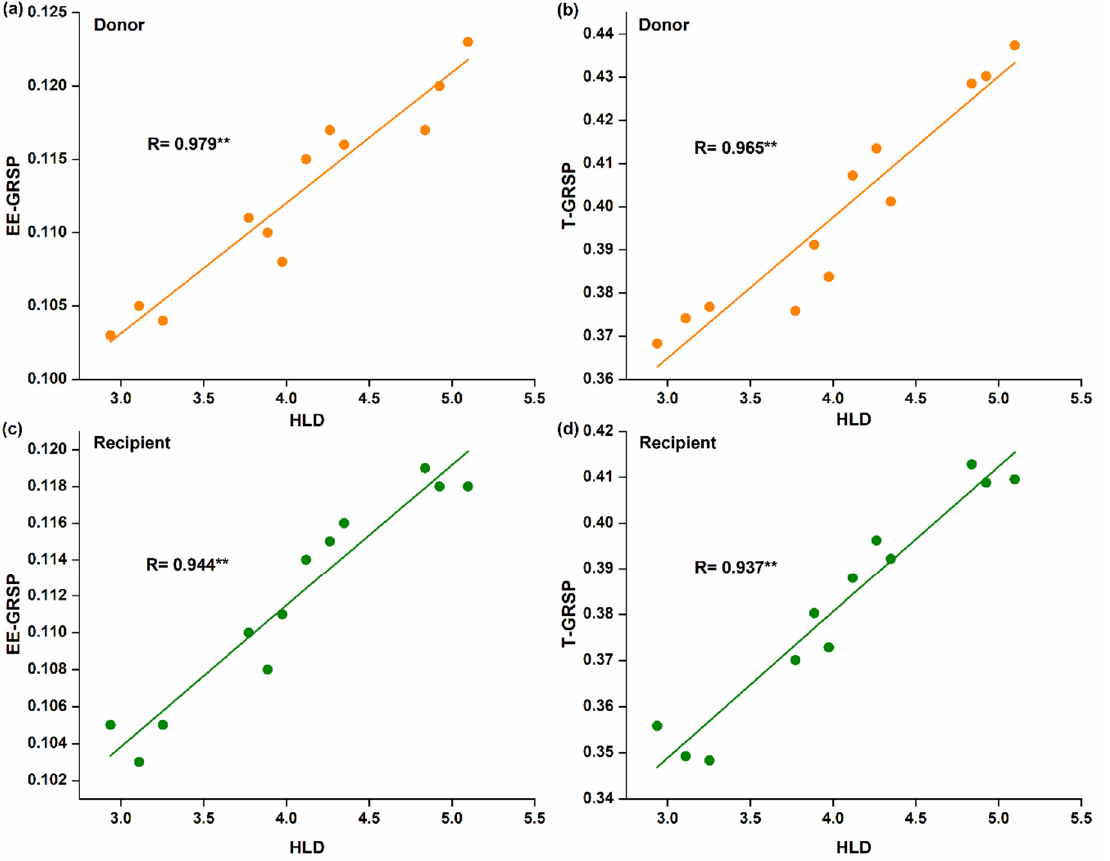
Figure 4. Linear correlation between hyphal length density and glomalin-related soil proteins (GRSPs) fractions; ( a , b ) in the donor plant; ( c , d ) in the recipient plants ( n = 12).